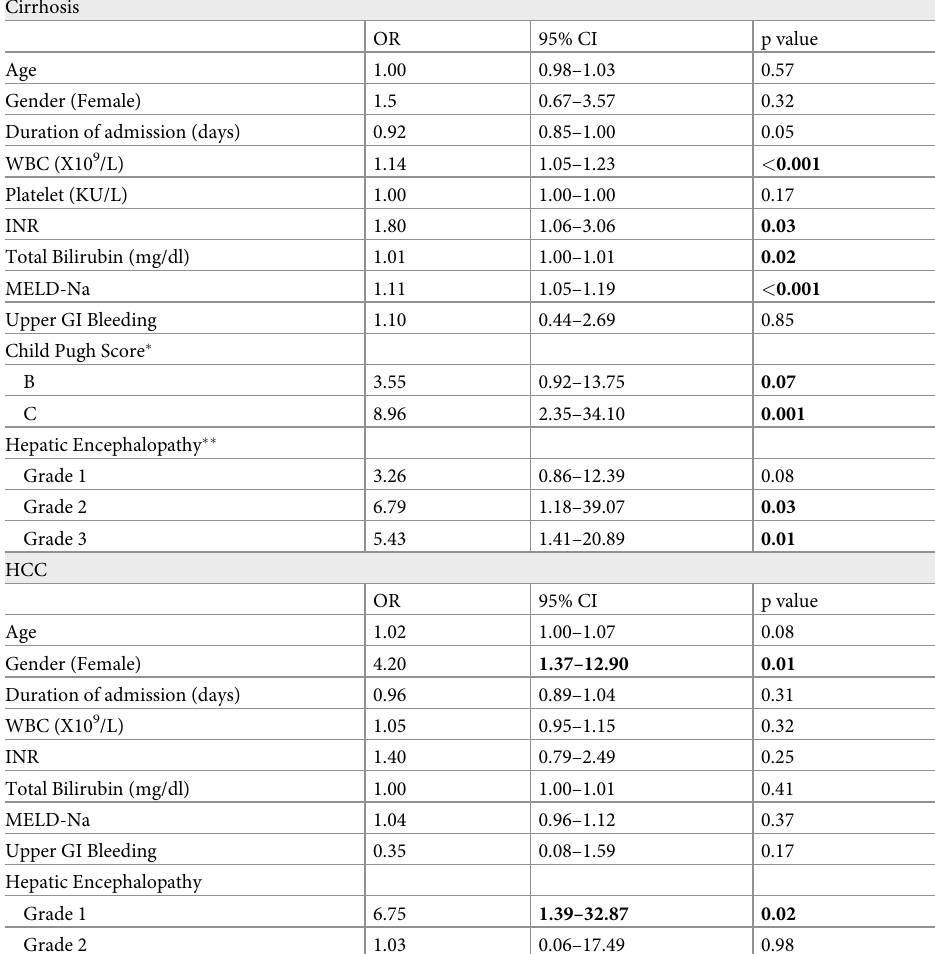
Table 4. Univariable logistic regression analysis of variables associated with in-hospital mortality (outcome) from liver cirrhosis and